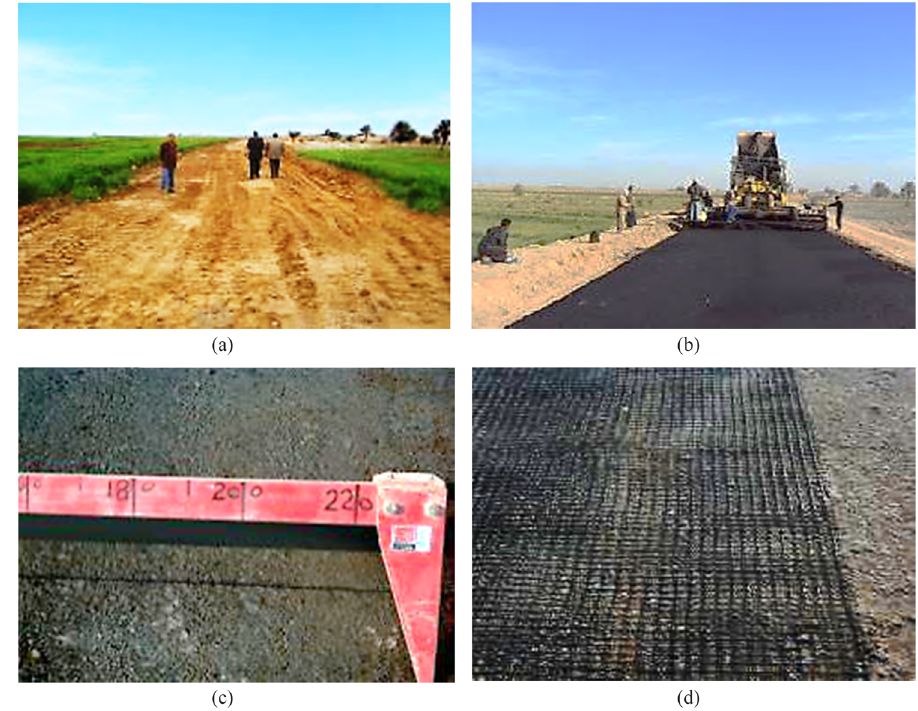
Figure 8: Site preparation. ( a ) High plasticity subgrade, ( b ) wearing layer layout, ( c ) rigid iron beam, and ( d ) geotextile